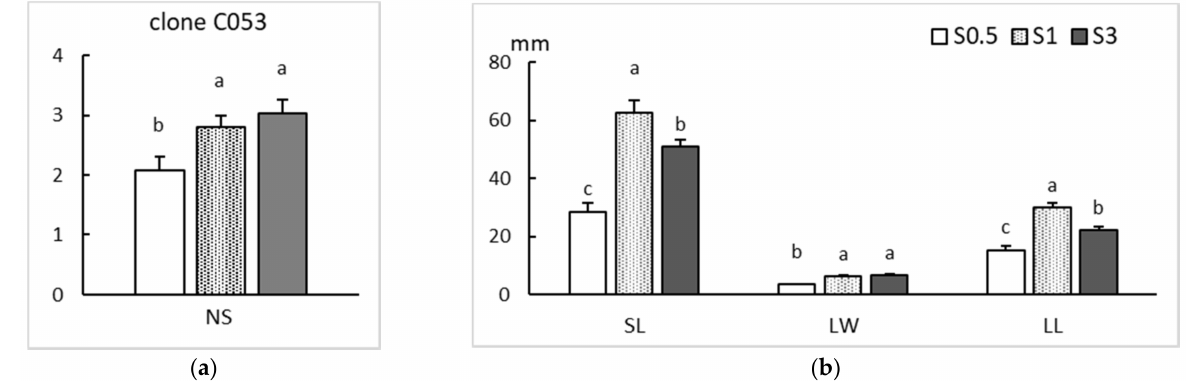
Figure 3. Effect of sucrose supplementation (0.5, 1 and 3%) on proliferation rates of apical sections of clone CO53 shoots cultured by continuous immersion. ( a ) Number of shoots (NS). ( b ) Length of the longest shoot (SL) and length (LL) and width (LW) of the largest leaf per explant. Values are the mean ± standard error from two replicate trials each with 2 bioreactors (64 explants/treatment). For each variable, different letters indicate significant differences at p < 0.05.